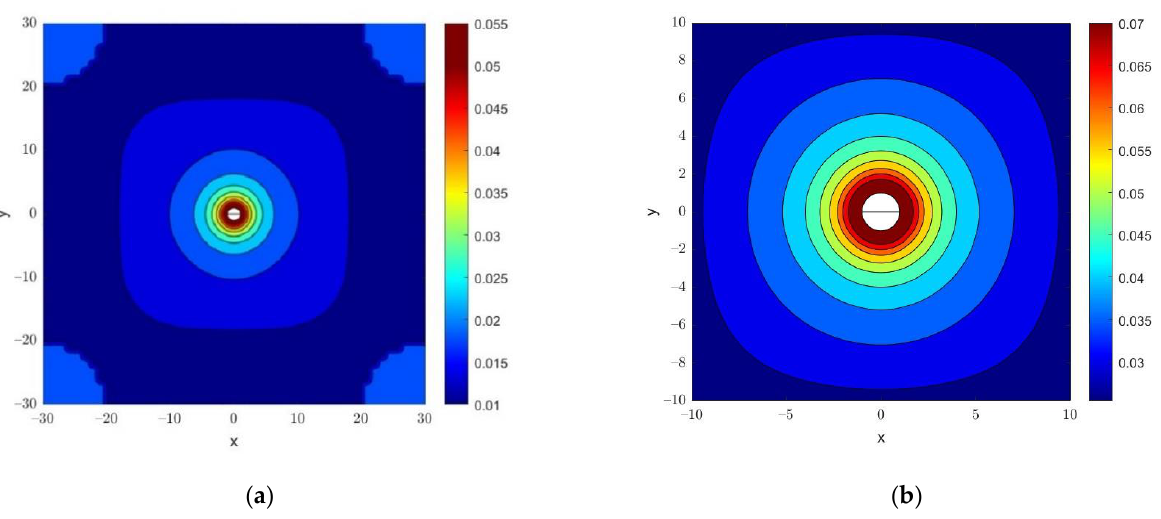
Figure 5. Radiated wave amplitude distribution on a free surface using Sommerfeld radiation condition: ( a ) low-frequency wave ( ω = 1.5 rad/s); ( b ) high-frequency wave ( ω = 3.0 rad/s).